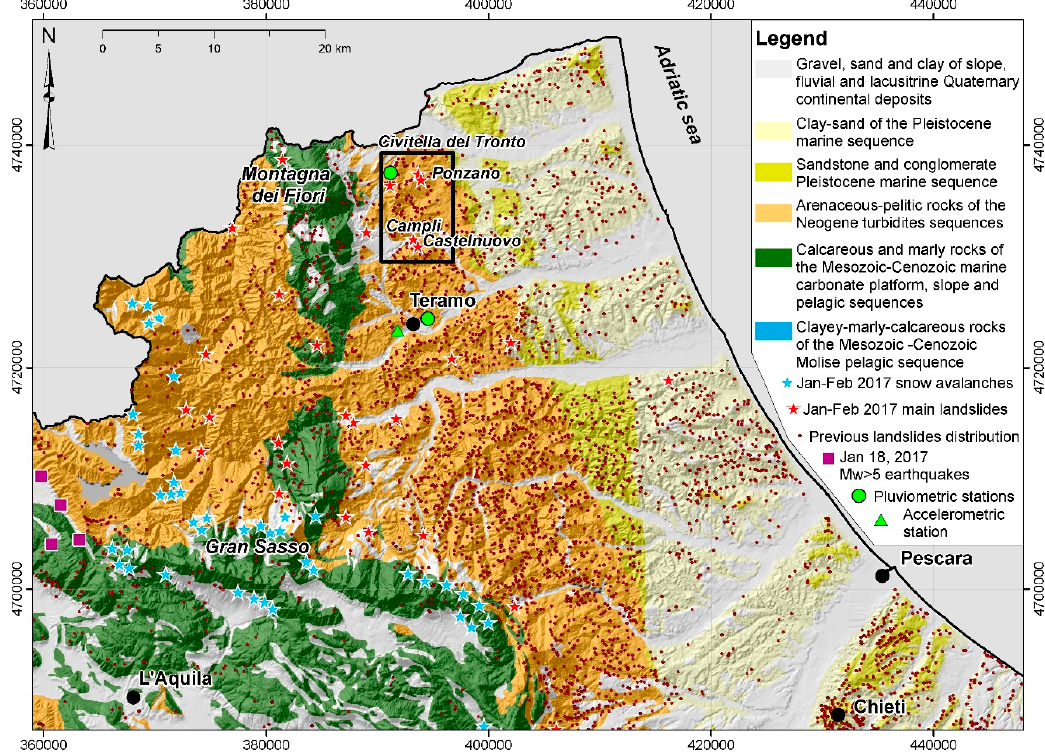
Figure 2. Lithological scheme of the NE-Abruzzo region and distribution of the main landslides.